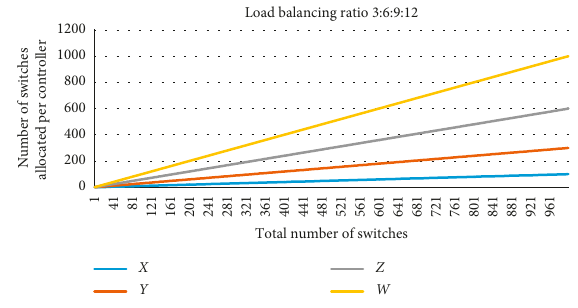
Figure 11: Load balancing for four slave controllers with ratios 3: 6: 9:12. Table 2: Experiments among five controllers.